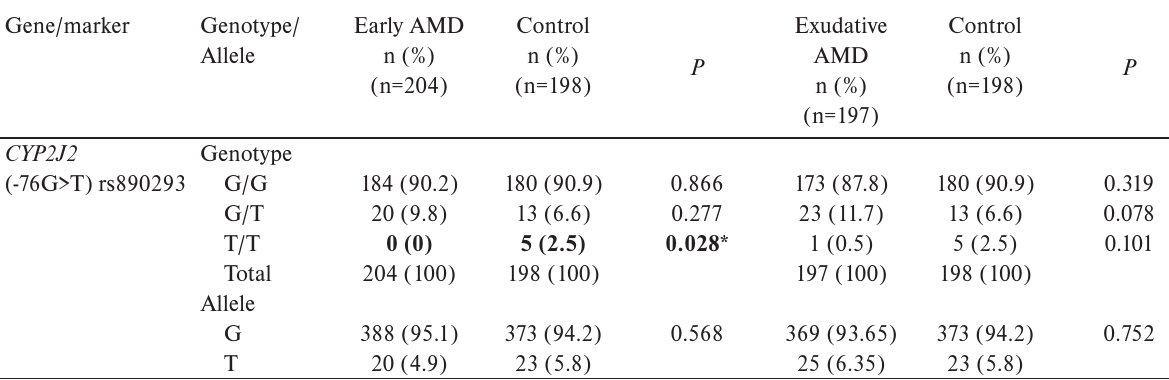
Table 2. Frequency of CYP2J2 (-76G>T) rs890293 genotype in patients with early and exudative age-related macular degeneration (AMD) and in control